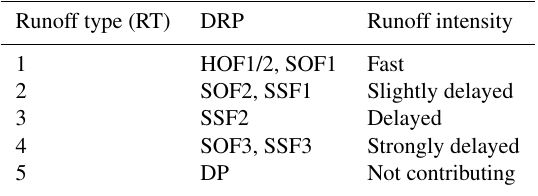
Table 2. Reclassification of DRPs according to runoff types (HOF: Hortonian overland flow; SOF: saturation overland flow; SSF: sub- surface flow; DP: deep percolation; 1 represents an almost immedi- ate reaction, 2 a slightly delayed one, and 3 a strongly delayed one). Adapted from Naef et al. (2000).